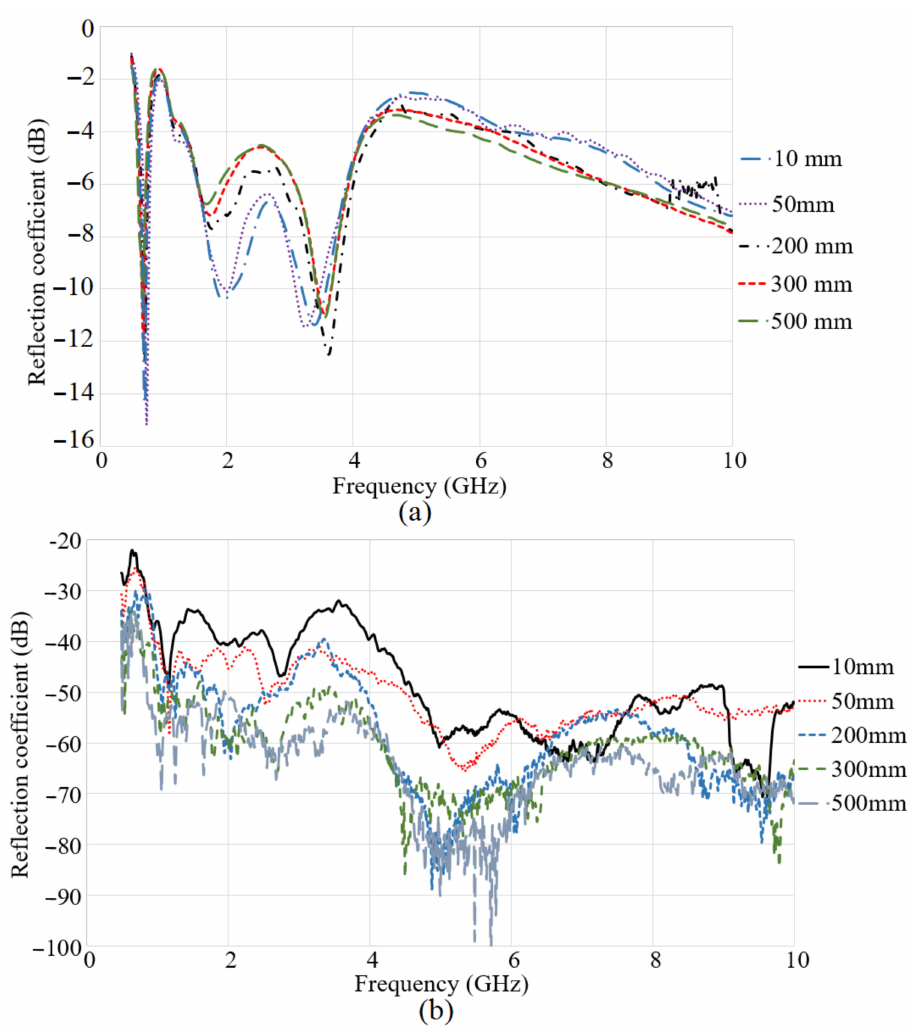
Figure 12. The reflection ( a ) and transmission coefficient ( b ) results when one antenna is at the surface and another is